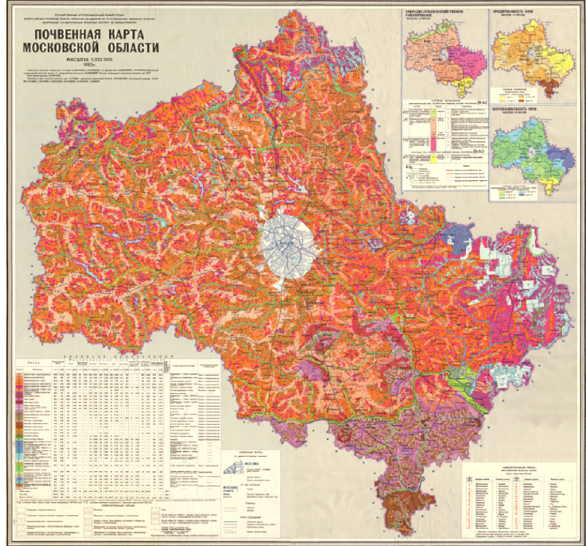
areaFigure 2. The soil map of the MR, 1:300 000,